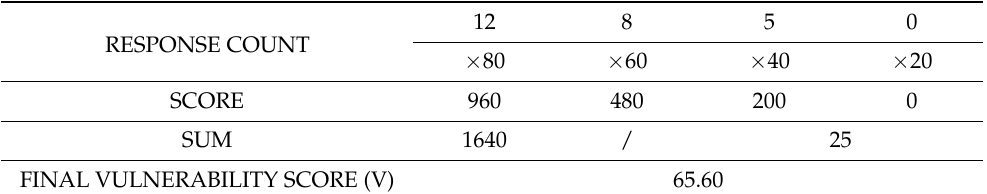
Table 11. Calculation of the degree of responsiveness.